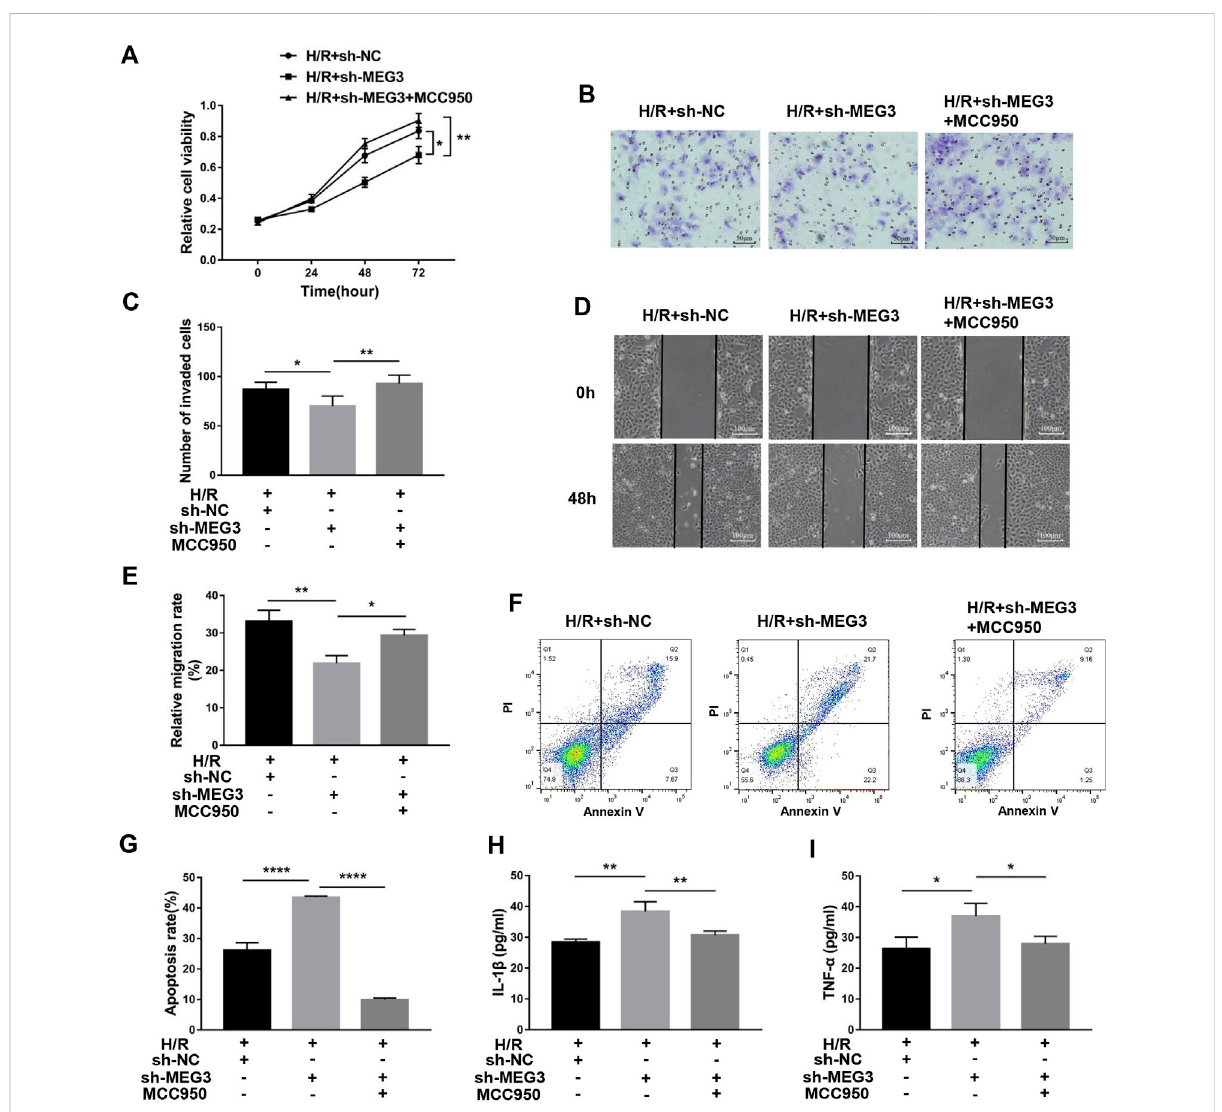
FIGURE 9 Suppressing NLRP3 expression alleviated the effect of MEG3 knockdown on trophoblast function. (A) Cell proliferation was determined by CCK-8 assay. (B,C) Cell invasion ability was determined by transwell assay. (D,E) Cell migration ability was determined by scratch assay. (F,G)